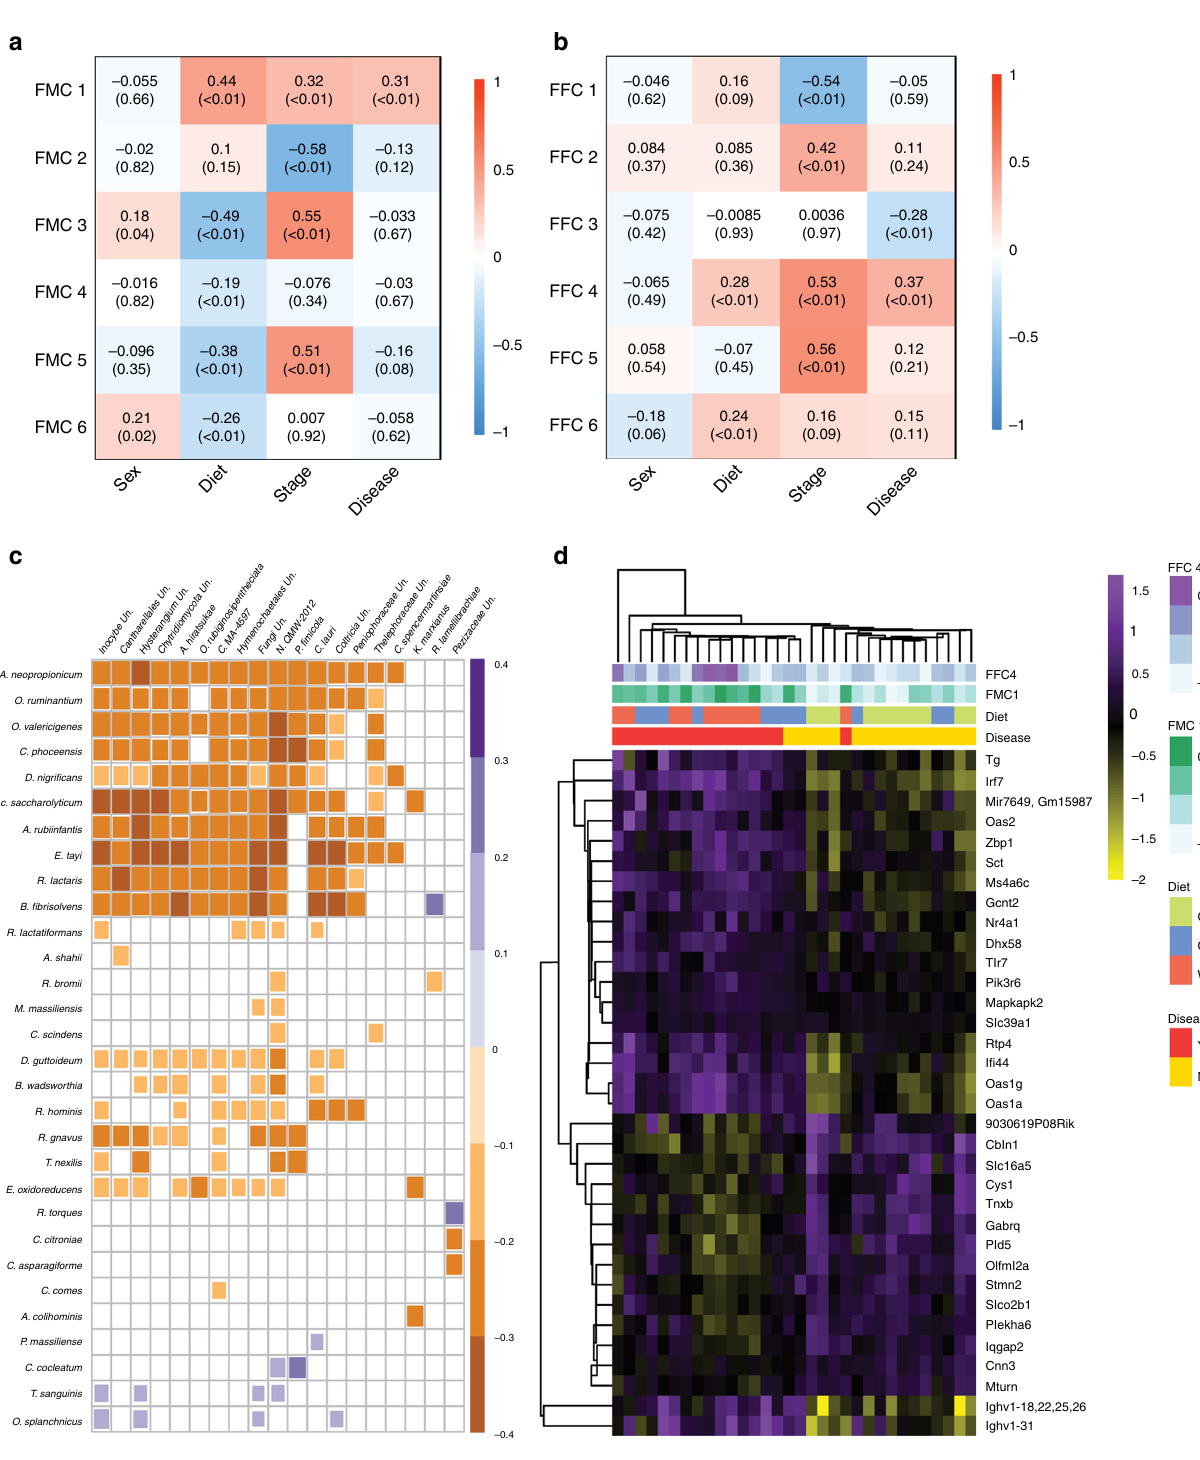
microbial and fungal composition (Fig. 5d). Out of the identi fi ed functional communities, we found FMC3, FMC5, and FFC6 to be associated with the production of ANA (Fig. 5e; Supplementary Fig. 4). After correlating the RNA-Seq data to FMC3, FMC5, and FFC6, we identi fi ed 1980, 429, and 102 differentially expressed genes, respectively (Supplementary Data 11 – 13). A comparison of differentially expressed genes from above analysis with fi ne- mapped eight genes for ANA QTL led single common candidate gene, i.e., Tnxb (Fig. 5g). The expression levels of Tnxb negatively correlated with both FMC3 and FFC6, and were upregulated